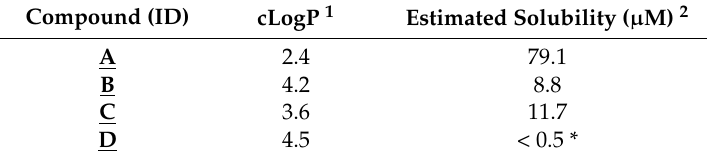
Figure 5. Turbidity at 400 nm as a function of concentration values measured for ( a ) compound A , ( b ) compound B , ( c ) compound C and ( d ) compound D . All solutions were prepared in HEPES buffer (10 mM, pH = 7.4) containing MgCl 2 (2 mM) and CaCl 2 (1 mM) salts. The final DMSO concentration in each sample was 1.0% ( v / v ). Each experiment was performed in triplicate. Table 3. cLogP and estimated solubility values for each compound ( A , B , C and D ).